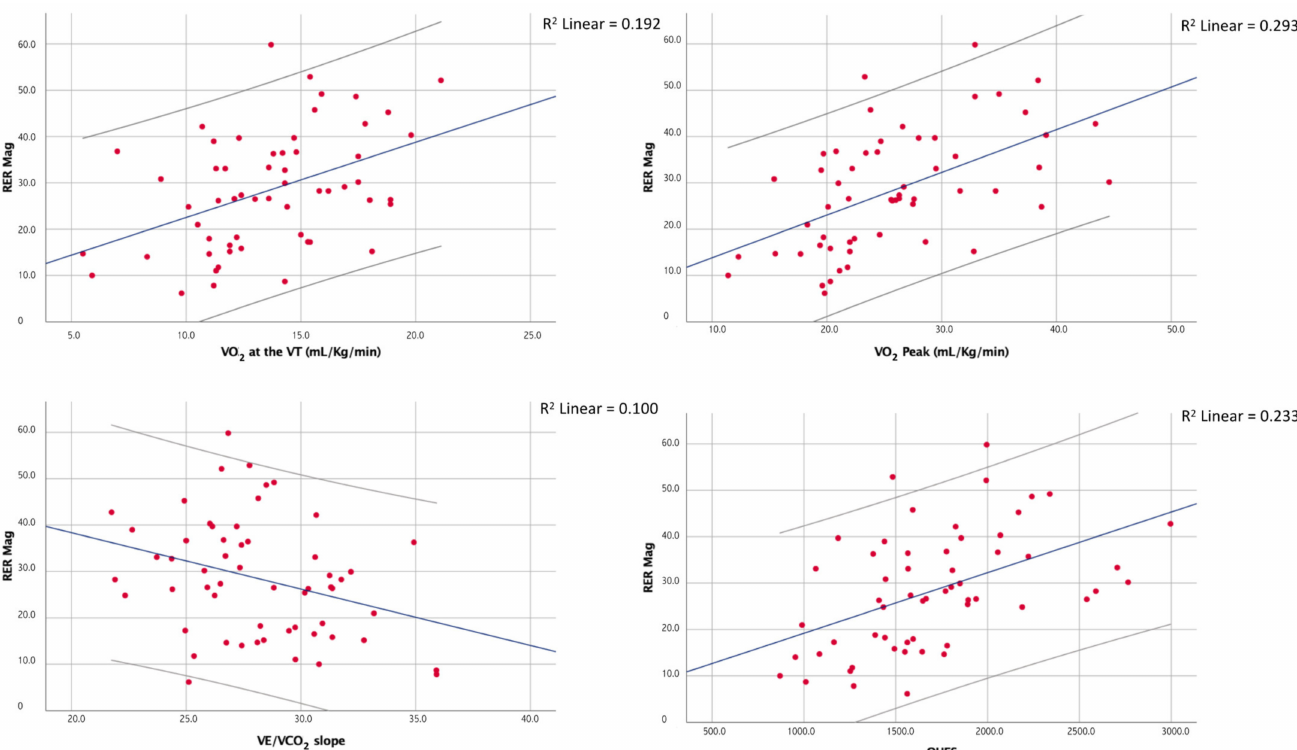
Figure 2. Correlations between the magnitude of the overshoot of the RER and a few of the main CPET indices of cardiorespiratory fitness and efficiency.